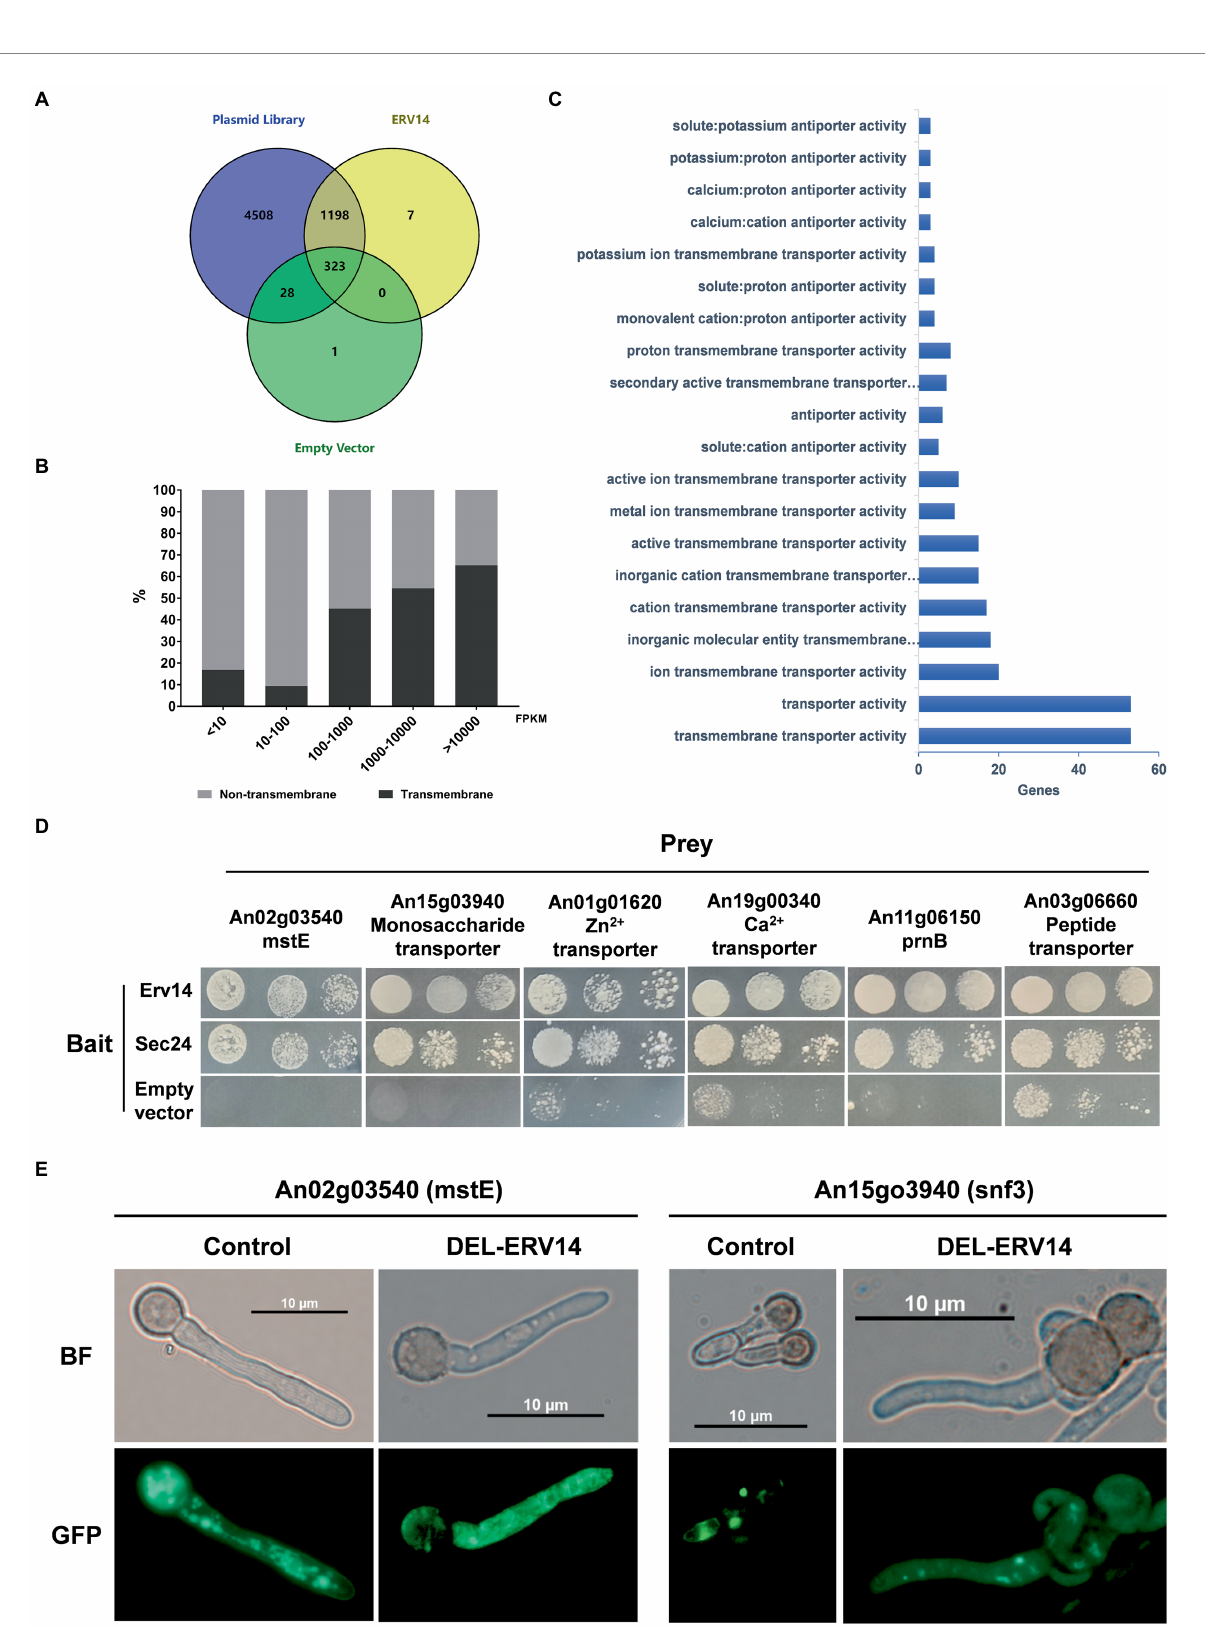
FIGURE 4 Identification of transporters potentially transported by ERV14 by Y2H high-throughput screening. (A) Venn diagrams of the number of overlapping proteins identified in the plasmid library, the empty vector, and the ERV14. (B) The proportion of transmembrane and non-transmembrane proteins in the ranges of different FPKM values. (C) Functional clustering of “Molecular Function” for transmembrane proteins in the ERV14 interactome. GO distribution of annotated A. niger genes was generated using g: Profiler [g: profiler – a web server for functional enrichment analysis and